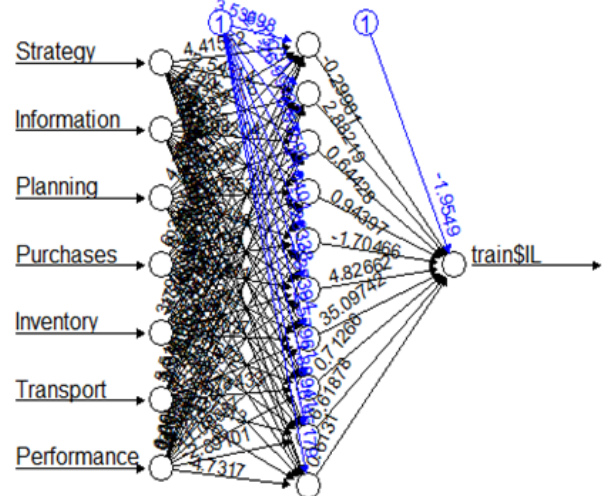
Figure 3. Multilayer perceptron neural network model of homogeneous